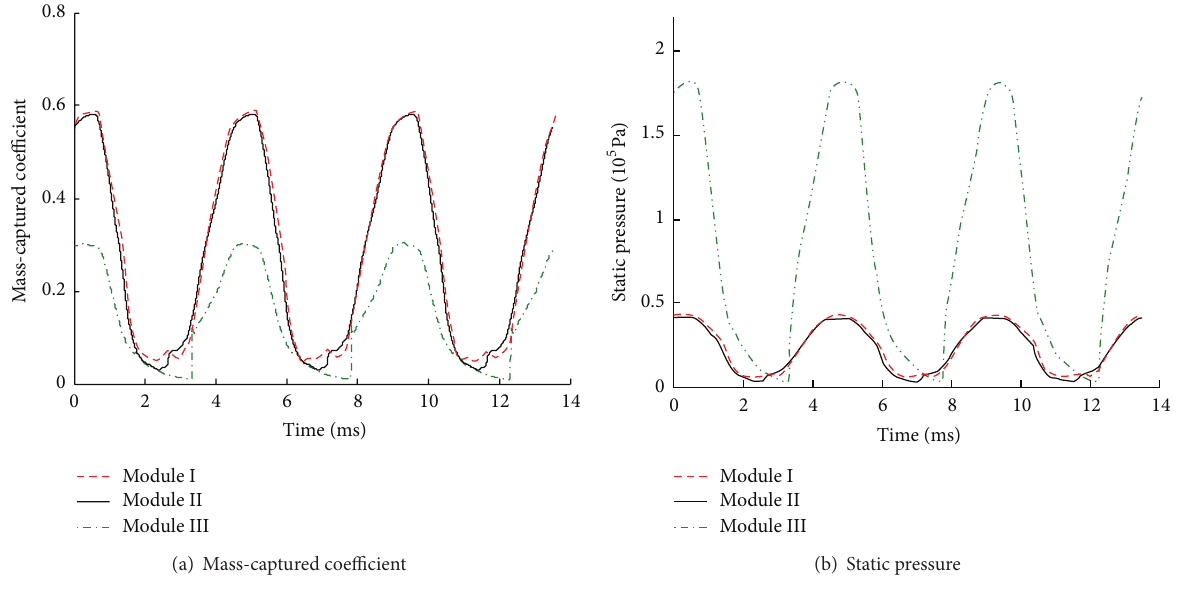
Figure 8: The histories of mass-captured coefficient and static pressure at the exit of